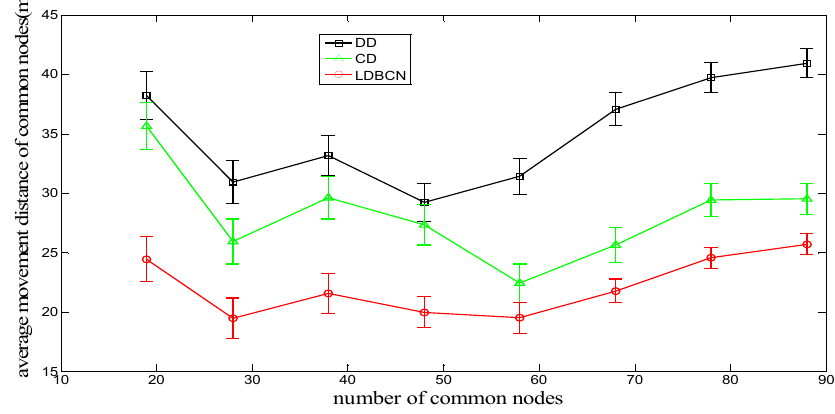
Figure 8. Average movement distance of common nodes for dispatch algorithms.